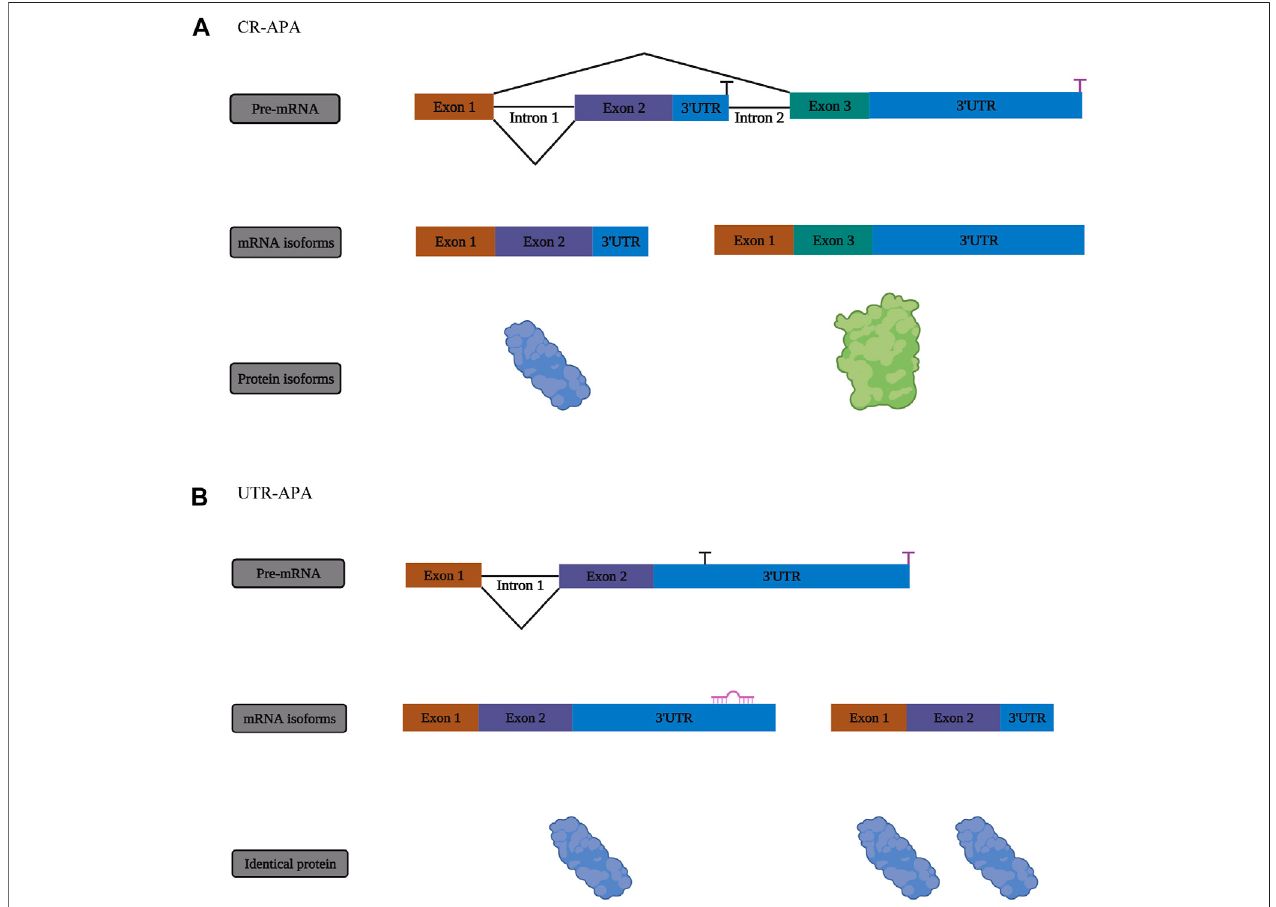
FIGURE 2 | The mechanism of alternative polyadenylation (APA). (A) One form of APA, termed coding region alternative polyadenylation (CR-APA), occurs when the alternative polyA sites (PASs) are located within exons or introns. (B) Another form of APA is known as untranslated region alternative polyadenylation (UTR-APA) when alternative PASs are located in different regions of the 3 ′ -UTR, resulting in the identical protein isoforms.